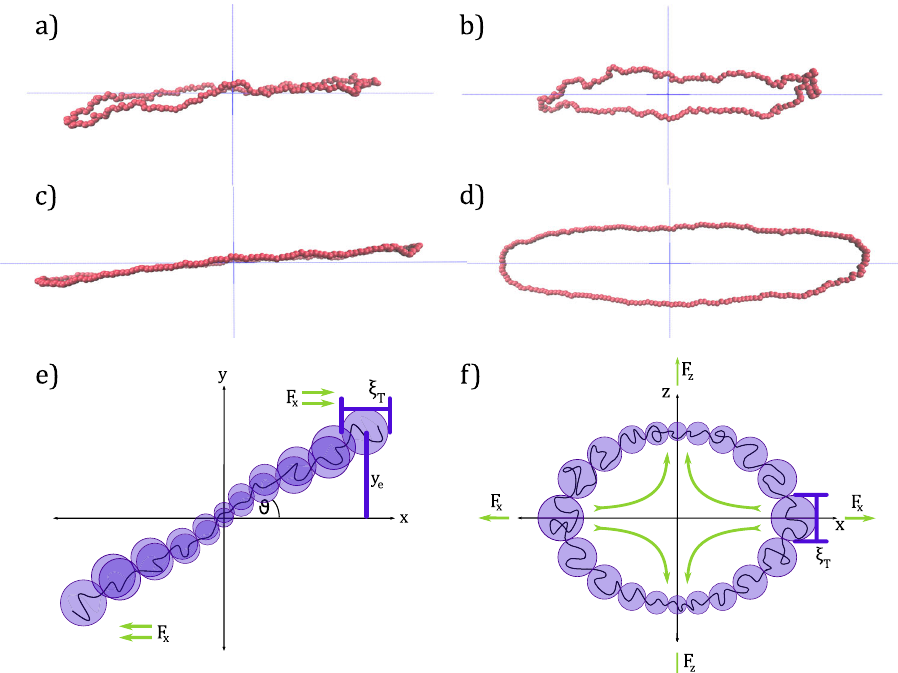
Fig. 6 Snapshots and sketches of a sheared ring. a Simulation snapshot of N = 200-ring at the onset of the in fl ation phase, on the fl ow-gradient ( x – y ) T Þ 0 : 5 m (cid:2) 0 : 5 a (cid:2) 1 (cid:6) . b As a , on the fl ow – vorticity ( x – z ) plane. c Stretched and in fl ated con fi guration on the fl ow-gradient plane. Wi = 145.06, _ γ ¼ 5 : 6 ´ 10 (cid:2) 3 ½ð k B T Þ 0 : 5 m (cid:2) 0 : 5 a (cid:2) 1 (cid:6) . d As c , on the fl ow – vorticity ( x – z ) plane. In all four panels a – d , the solid scale bar in the centre ( x – y ) plane. Wi = 543.95, _ γ ¼ 2 : 1 ´ 10 (cid:2) 2 ½ð k B extends to 5 σ in all directions. e Viewed projected on the fl ow-gradient ( x – y ) plane, the ring is rendered as a succession of blobs, the largest of which is located at the tips and has size ξ T . The elevation of the tip over the neutral ( fl ow – vorticity) plane is y e , and the tilt angle is θ . f Viewed projected onto the fl ow – vorticity ( x – z ) plane, the ring has an oval shape and it is stretched outwards in all directions due to the back fl ow of solvent (denoted by the curved green arrows), re fl ected at the two horseshoe-shaped regions at the